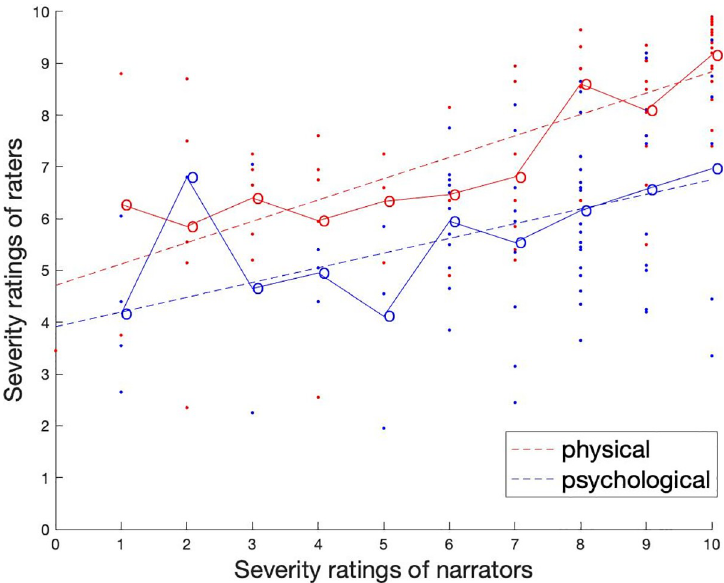
Fig 4. The severity of violence as evaluated by the raters as a function of the evaluation of the narrators for all participants (men and women) in Phase 2. The data are divided into physical (red) and psychological (blue) violence. Each dot (N = 340) represents one narration. The straight dotted lines are fitted linear curves. The circles with solid lines represent averaged severity